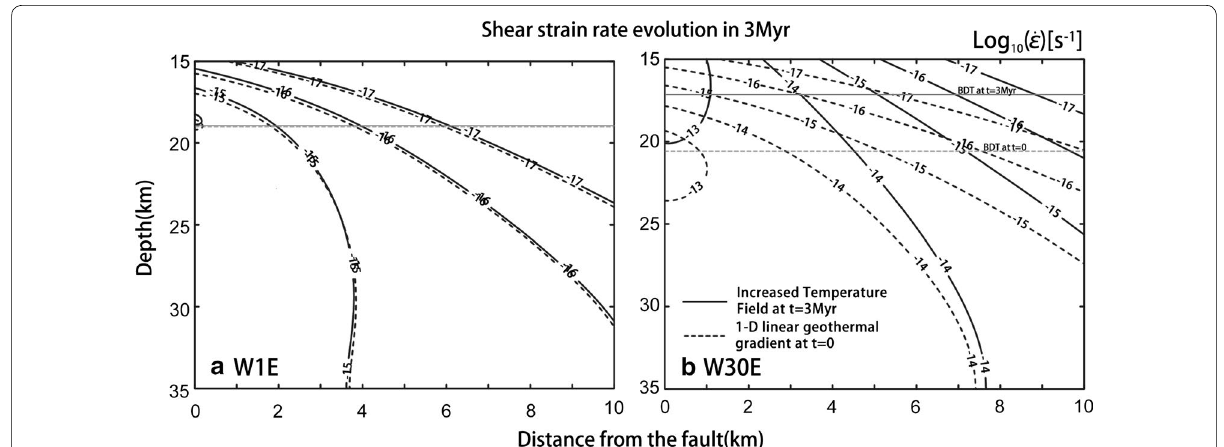
Fig. 9 Shear strain rate changed by increased temperature for a W1E and b W30E. The broken contour lines show the shear strain rate with the tem- perature field of a 1-D geothermal gradient, and the solid contour lines show the shear strain rate with the temperature field from a 3 Myr simulation. Gray broken lines and solid lines represent the BDT depth at t